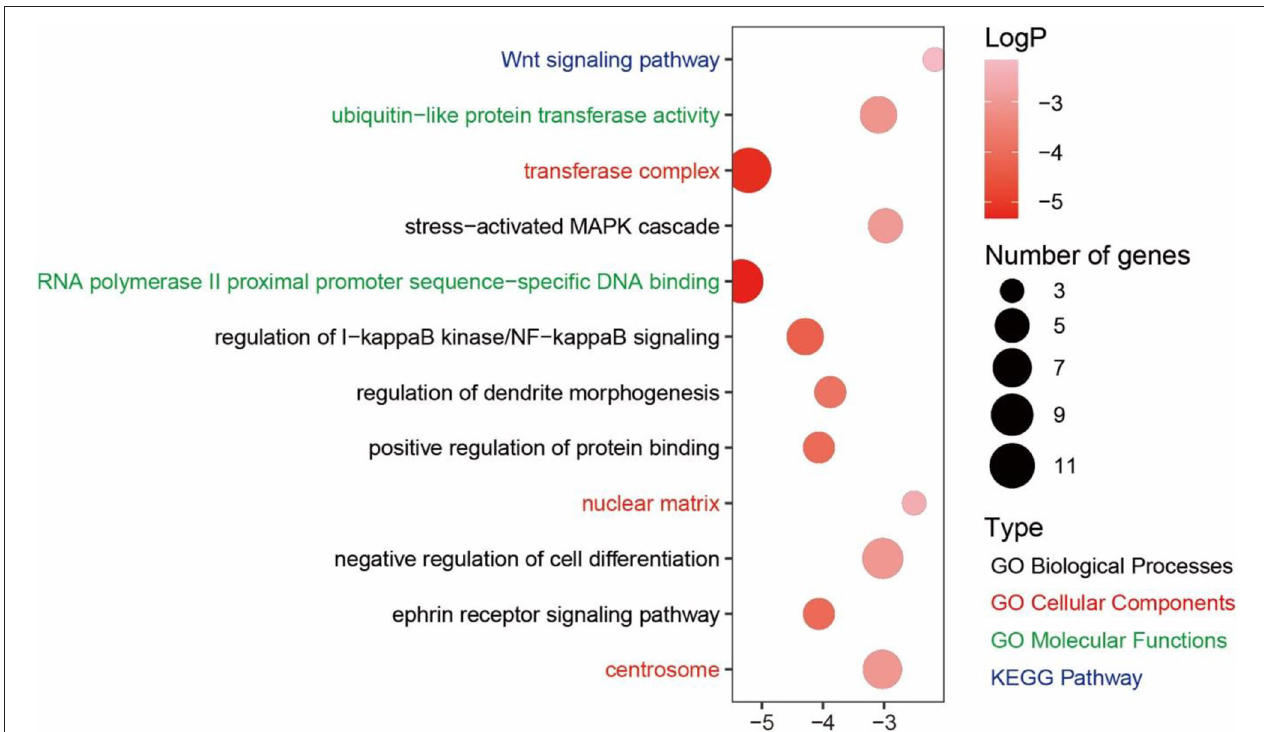
FIGURE 4 | Enrichment analysis of